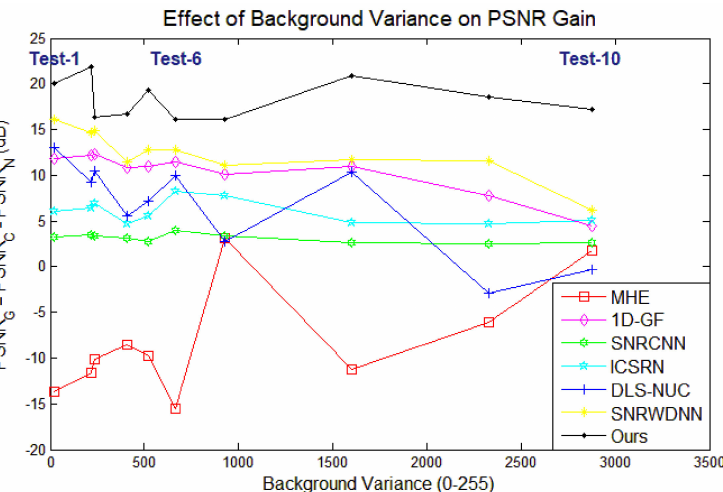
Figure 15. Line graph of each method performance on PSNR. The abscissa is the variance of the image background pixel value, and the ordinate is the difference between the corrected image PSNR and the nonuniformity image